Question: Provide a one-line summary of what is displayed.
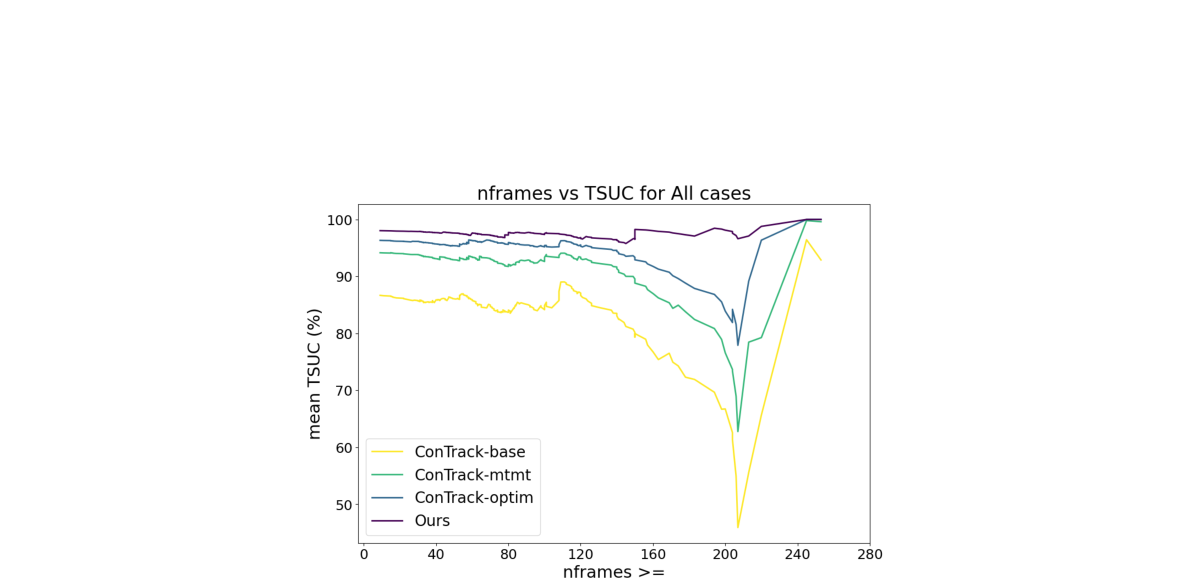
Answer: Robustness with respect to the sequence length: mean TSUC for all sequences greater than the frame count (nframes). Note the dataset consists of only 4 sequences with frame count greater than 210.